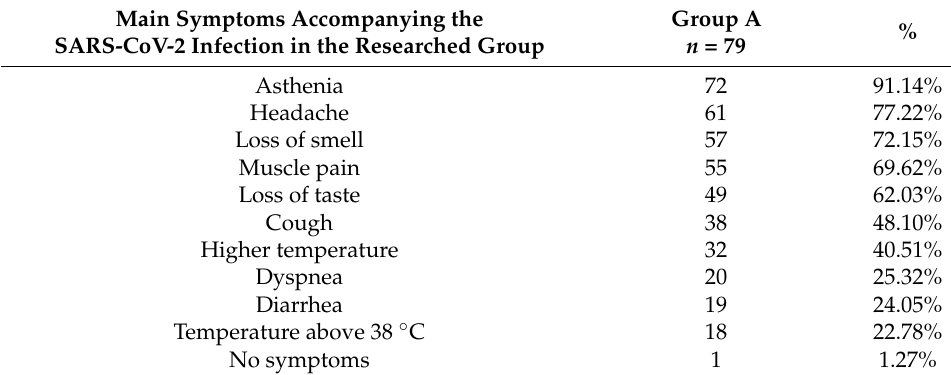
Table 2. Frequency of symptoms of COVID-19 infection in Group